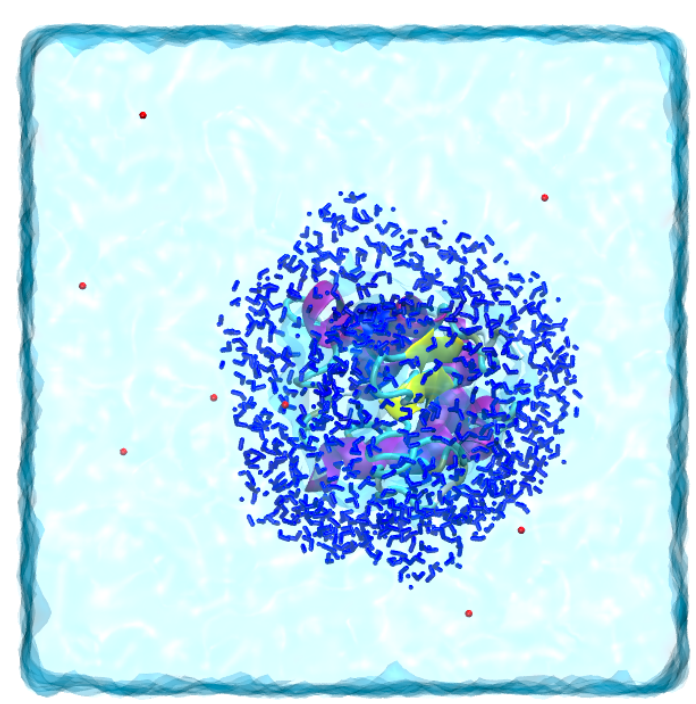
Figure 1. Snapshot of the system at T = 280 K: hydration water is shown in licorice structure (balls + sticks) and colored in blue, protein is depicted and colored highlighting its secondary structure, the rest of the water in the box is shown as a transparent surface. Cl − ions are shown in van der Waals representation and colored in